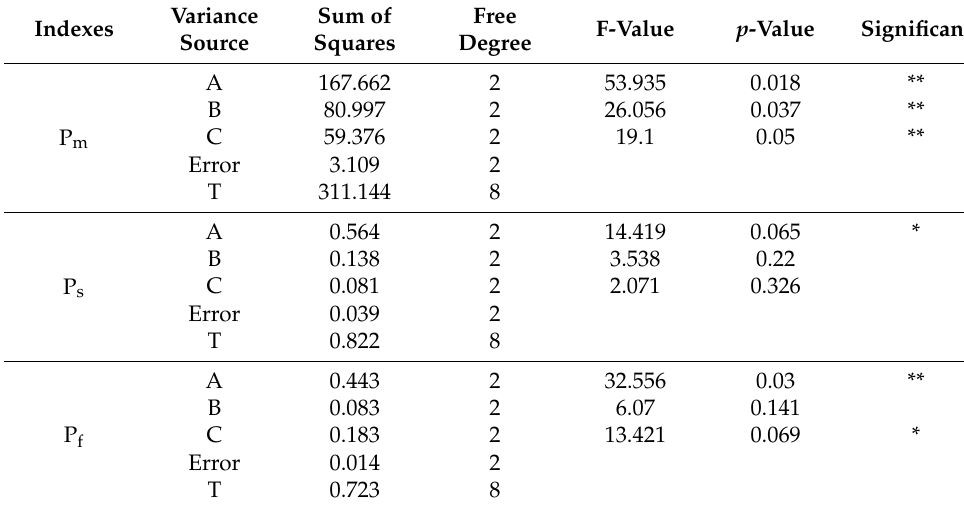
Table 7. Experimental variance analysis of pressed